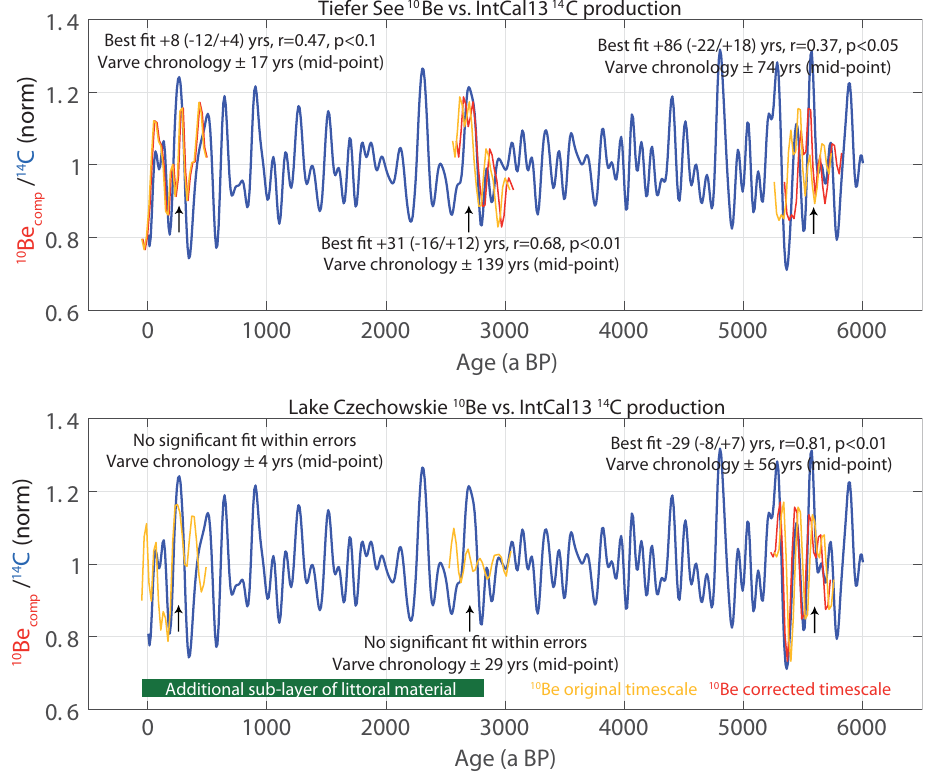
Figure 6. Synchronization of 10 Be composites ( 10 Be comp ) from Tiefer See (TSK) and Lake Czechowskie (JC) for the Maunder, Homeric and 5500aBP grand solar minima with 14 C production rates from the IntCal13 calibration curve (Muscheler et al., 2014). Best fits between the records were calculated using lag correlation, based on given chronological uncertainties (Dräger et al., 2017; Ott et al., 2016). Significance levels of the correlations were calculated using 10000 iterations of a nonparametric random phase test taking into account autocorrelation and trend present in the time series (Ebisuzaki, 1997). Uncertainties are given as the time spans in which the significances of the correlations are below their respective significant levels. 10 Be comp is shown on its original timescale and, if applicable, synchronized with IntCal13 14 C production rates. An interval with an additional sub-layer of resuspended littoral material in JC varves is indicated. Arrows mark the peaks of the targeted three grand solar